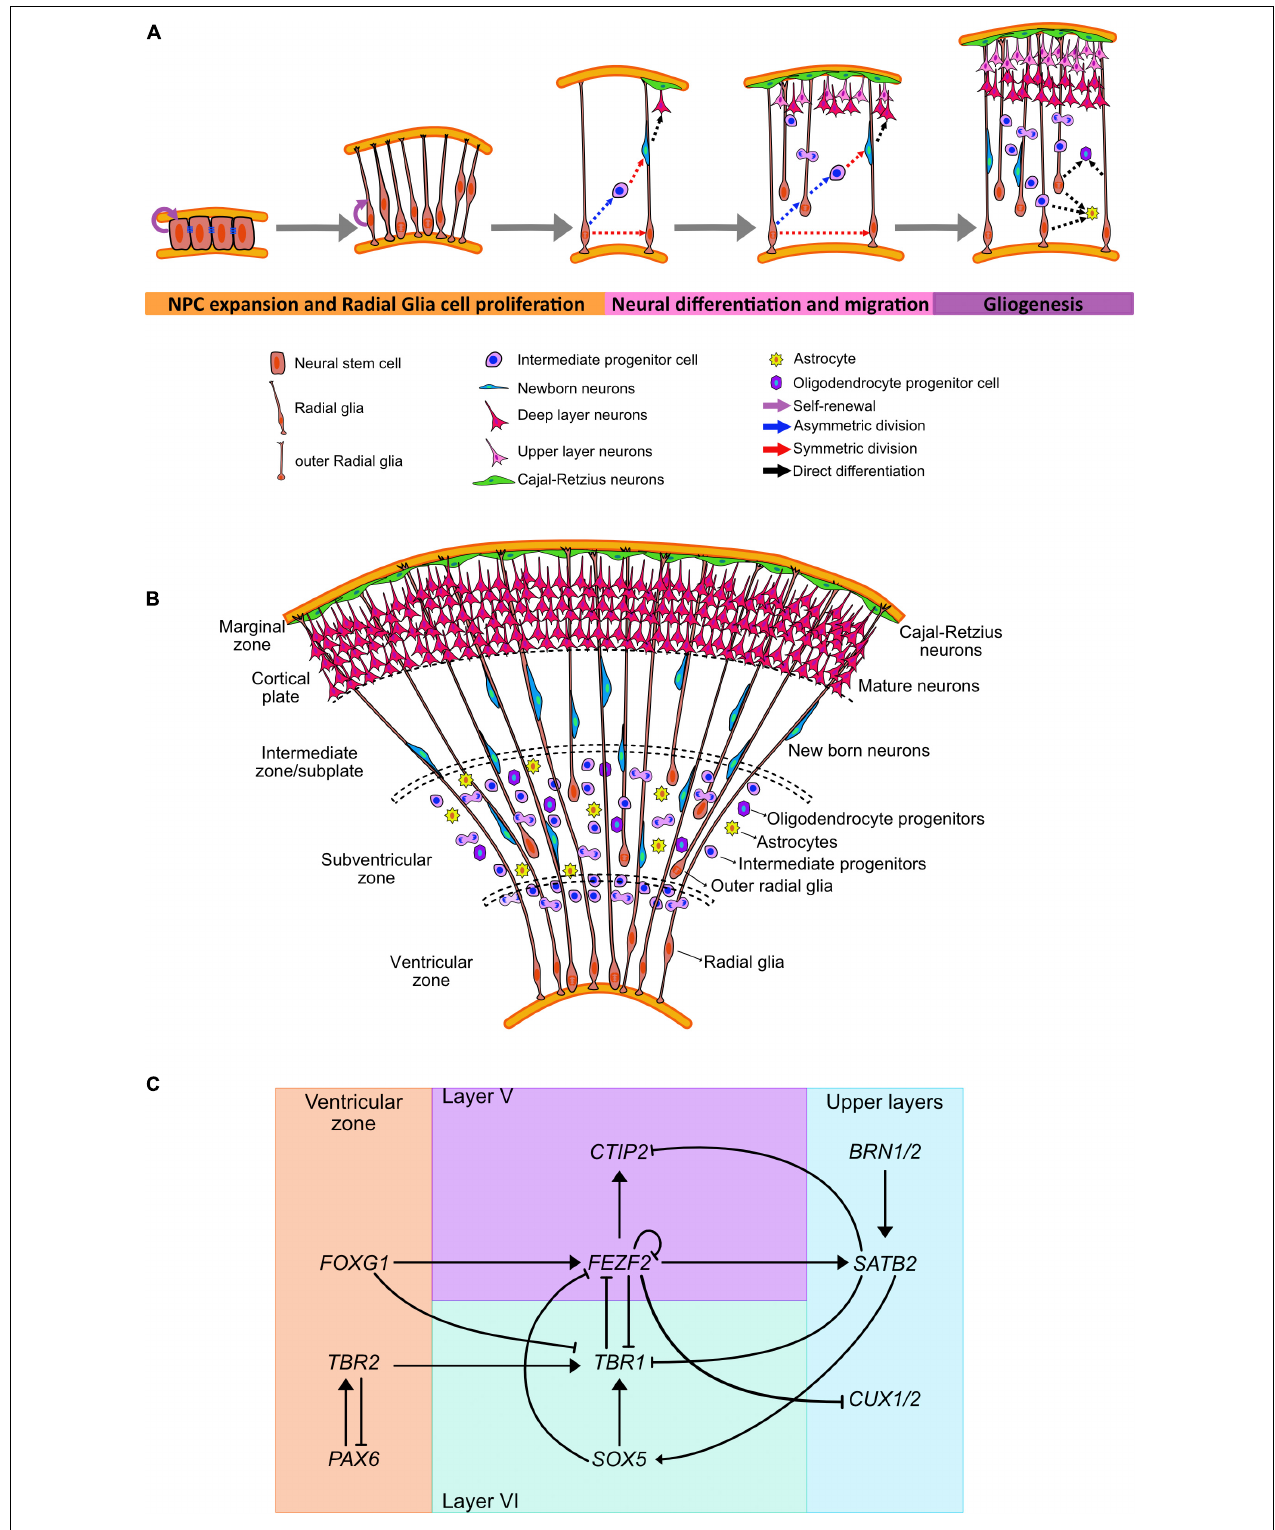
FIGURE 1 | Human neocortical development. (A) Schematic illustration of neurogenesis in the human cortex. (B) Cortical expansion in humans allows for the formation of different areas where progenitor lineages migrate, proliferate, and differentiate. (C) Transcriptional regulators and genes governing cell fate acquisition and specification during